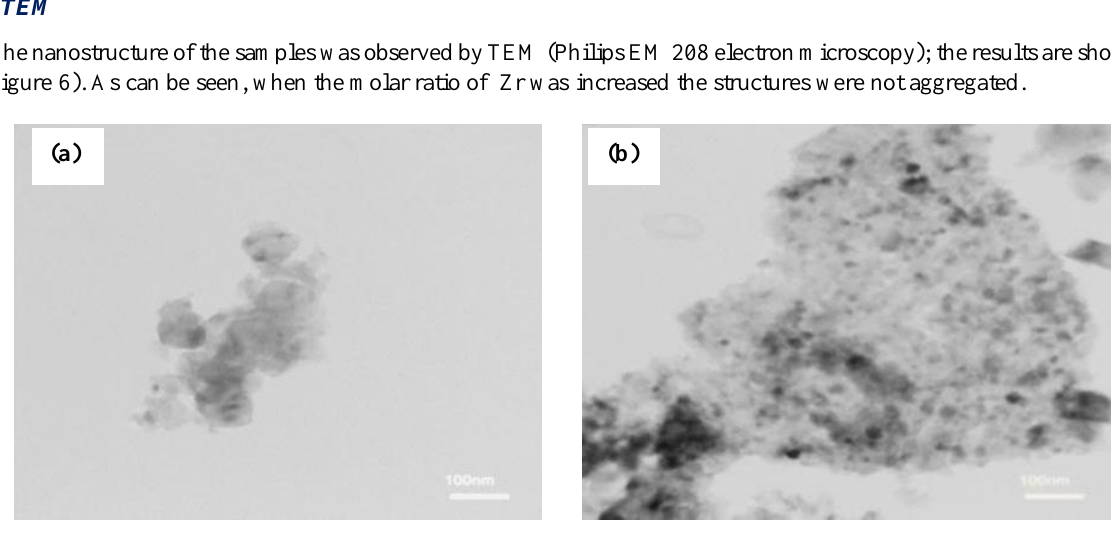
Figure 6. TEM images analysis of catalyst samples. (a) T, (b)